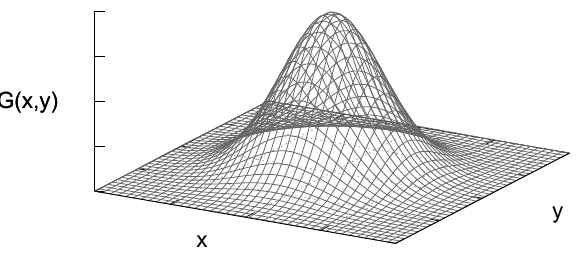
Figure 6. Gaussian distribution in 2D.